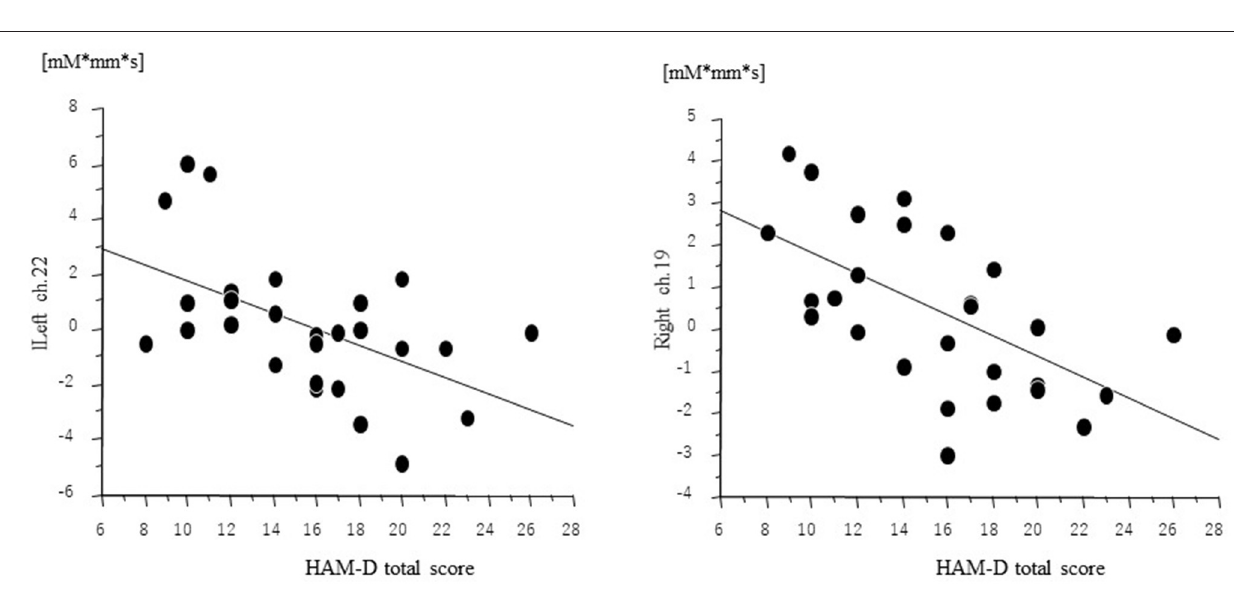
FIGURE 3 | Oxy-Hb grand mean waveforms and channels both with patient and control groups. Red dots indicate channels that significant difference between groups.